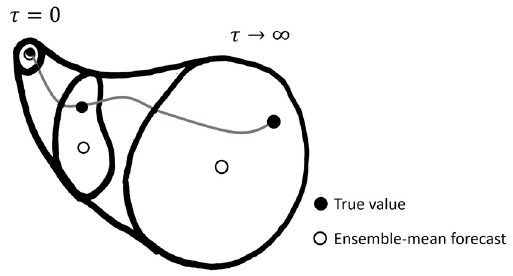
Figure 1. A schematic of time evolution of a single time segment of the true value and perfect model’s ensemble forecast. True value (solid line and closed circles) and the ensemble-mean perfect-model forecast (open circles) from the initial to the infinite lead time τ . The forecast expansion of the ensemble members is represented by the thick lines enclosed by their mean.